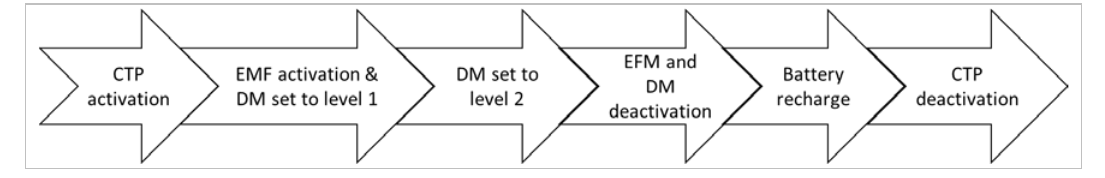
Figure 6. Functional test sequence.